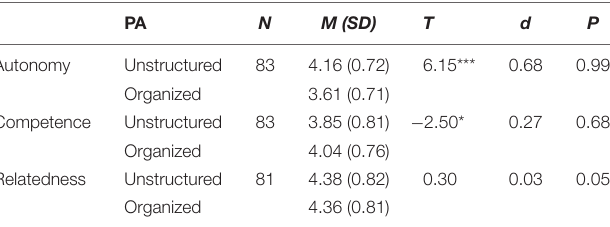
TABLE 4 | Satisfaction of basic psychological needs for unstructured and organized PA.